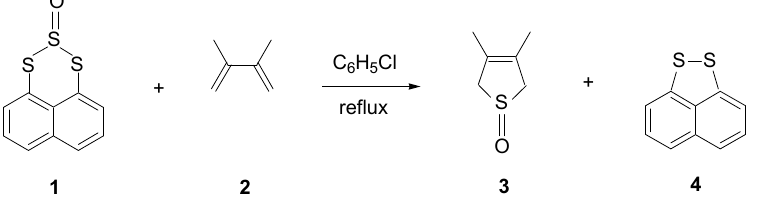
Figure 1. 7-sulfinylamino-7-azadibenzonorbornadiene